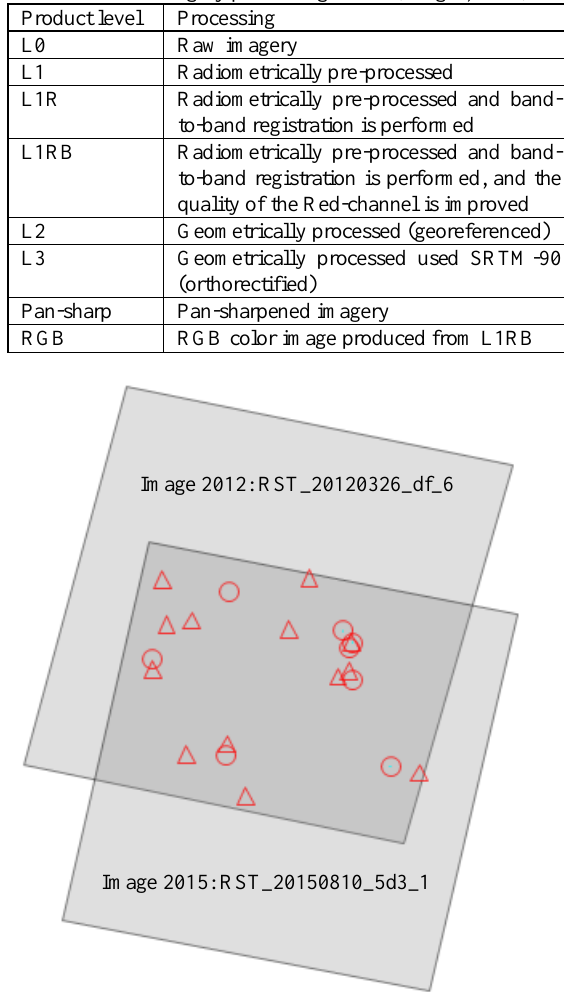
Figure 1. An overview of Kesan testfield. The red triangles denote the positions of the GCPs, the red circles denote the check points and the grey rectangles denote the coverage area of the two RASAT acquisitions.